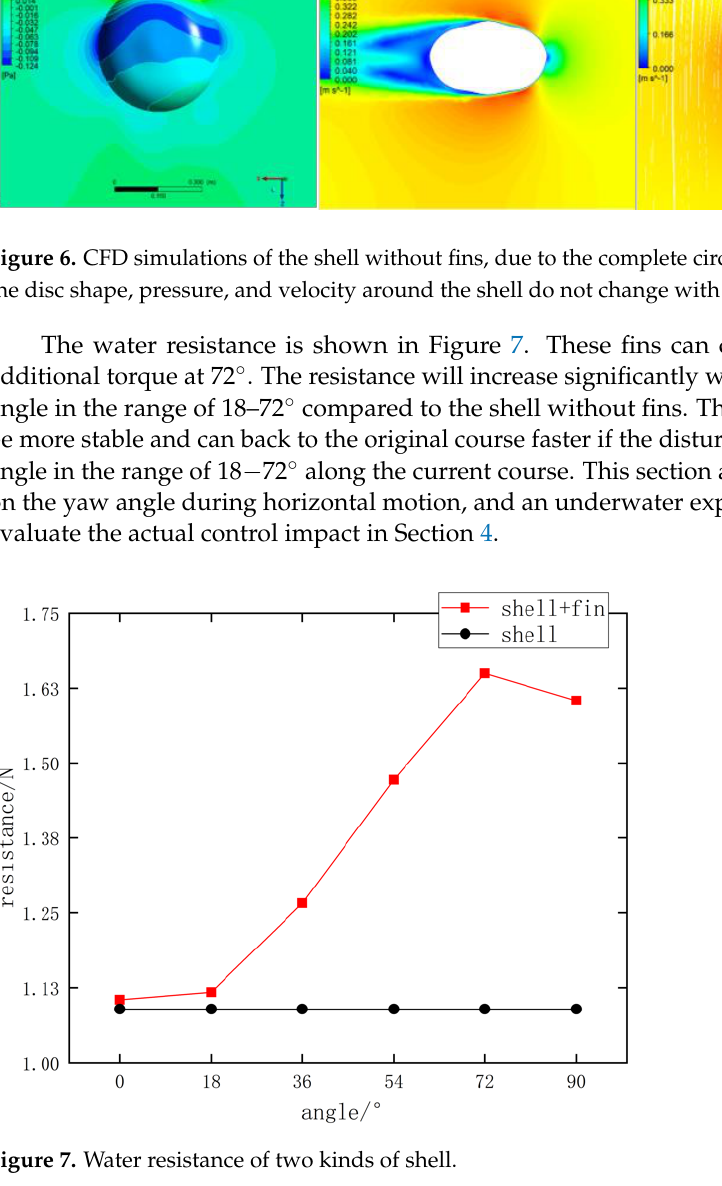
Figure 7. Water resistance of two kinds of shell.